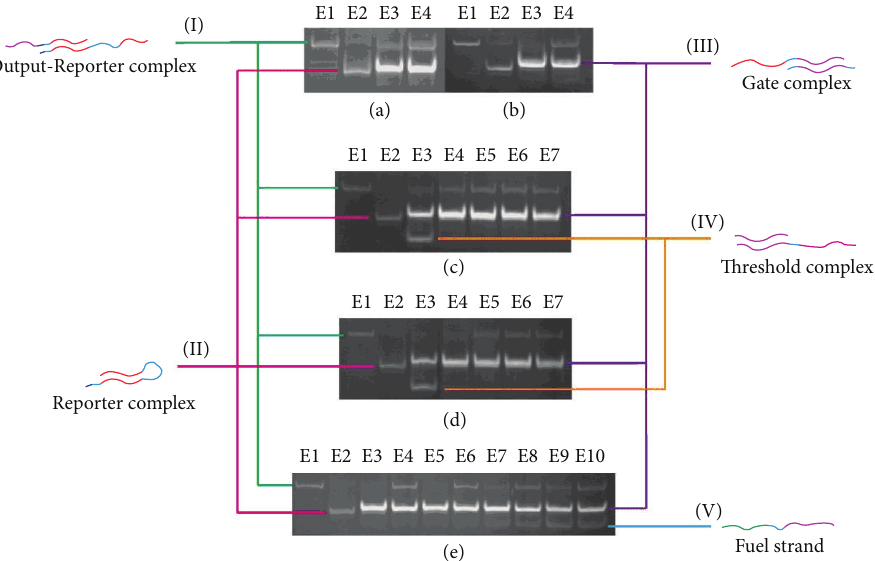
Figure 10: PAGE results of all experiments; identities of all samples are on the top of the